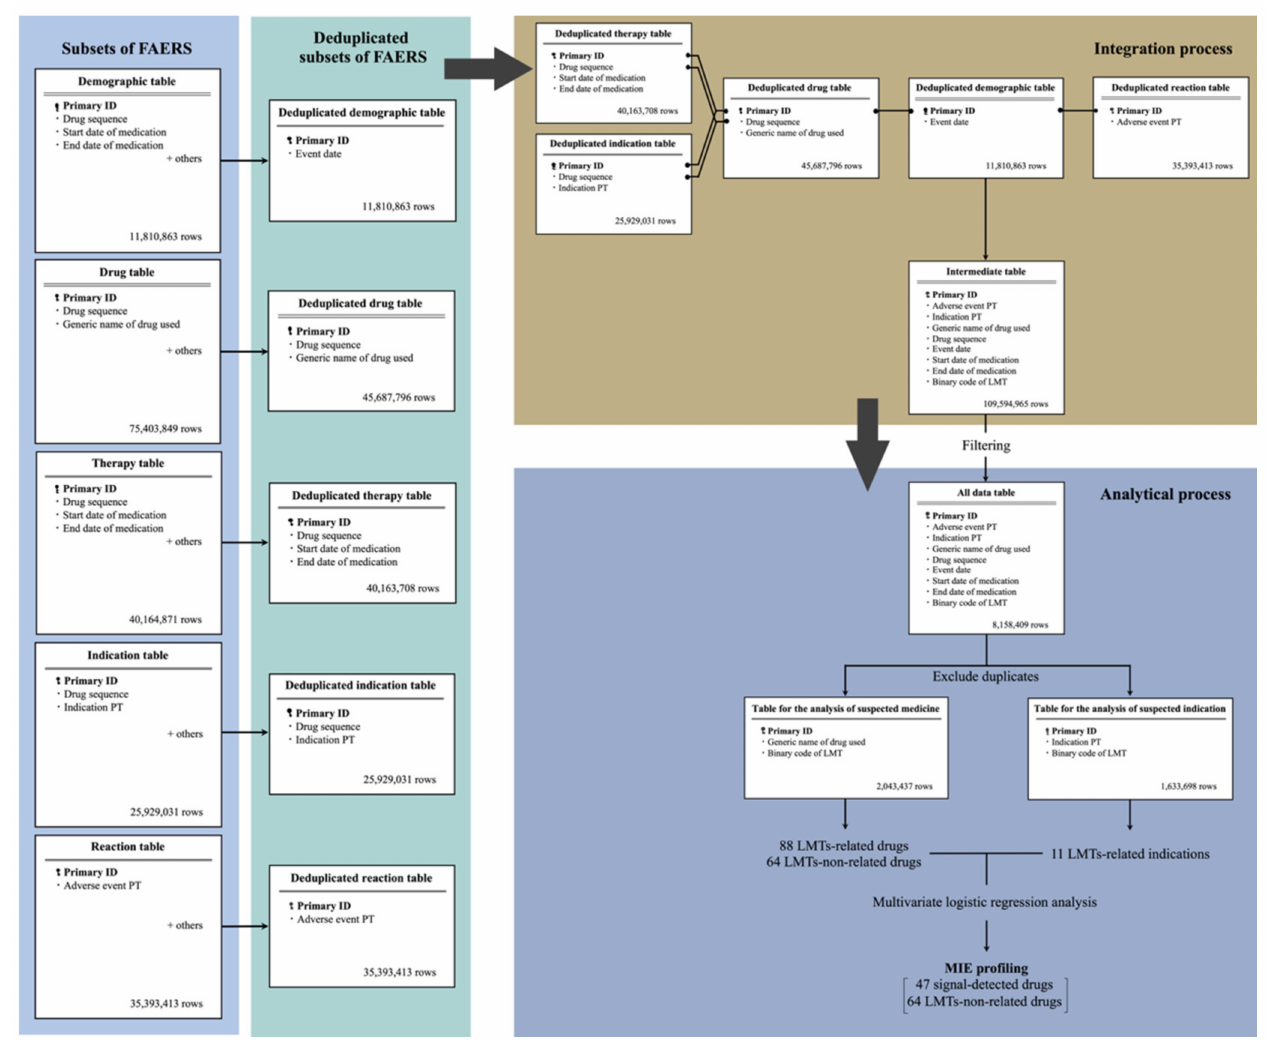
Figure 1. Overview of this study. Five subsets of the FAERS database were deduplicated (the square of deduplicated subsets of FAERS). Deduplicated five subsets were merged and integrated into one table (integration process), and information such as start date of medication, end date of medication, and event date were filtered. All information that could be a reason for pseudo-signal were excluded. “All data table” (>8 million) was used for the detection of LMT-inducing drugs and LMT-related indications, and signal-detected drugs were evaluated in detail with multivariate analysis. Finally, MIEs specific to signal-detected drugs were calculated (analytical